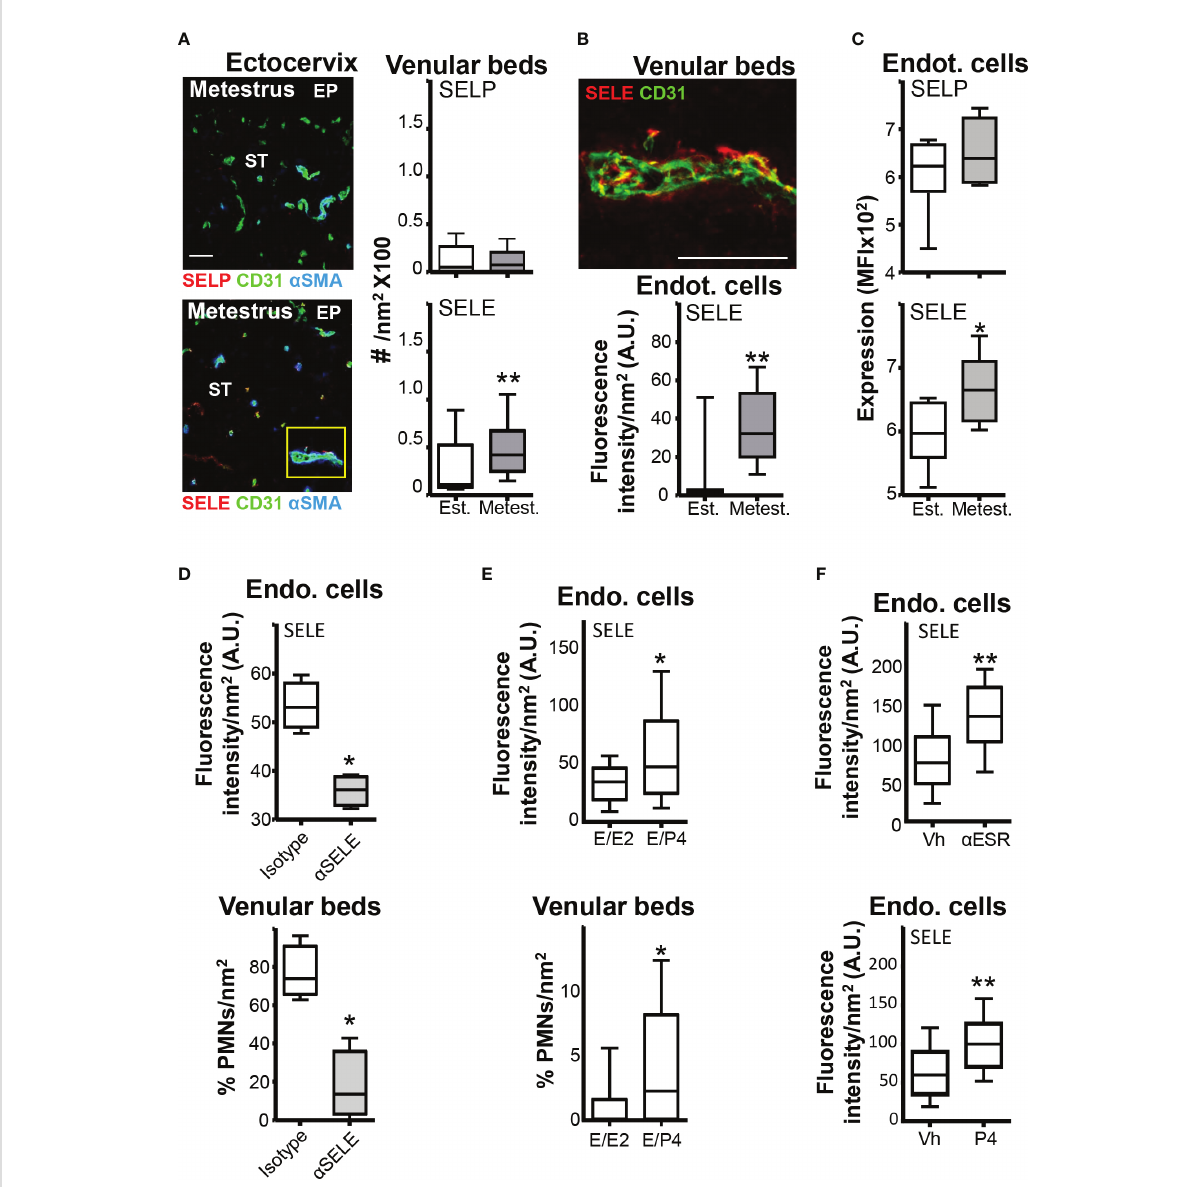
FIGURE 4 SELE and SELP expression in the ectocervix venular beds. Adult female mice were selected by vaginal smear. (A) Photomicrograph of the vascular and venular beds SELP or SELE stained in the ectocervix of estrus and metestrus mice and quanti fi cation. (B) Photomicrograph of the yellow square in (A) Endothelial cells from venular beds SELE stained in the ectocervix of estrus and metestrus mice and quanti fi cation of the expression. A and B data were calculated in at least 3 different sections of each sample (n=6 mice per group). (C) Flow cytometry average MFI of the SELP or SELE expression in the vaginal venular endothelial cells (n=6 mice per group). (D) Anti-SELE treated mice. SELE expression in endothelial cells and quanti fi cation of neutrophils intraluminal adhesion in venular beds. (E) Hormone-treated ovariectomized mice. SELE expression in endothelial cells and quanti fi cation of neutrophils intraluminal adhesion in venular beds. (F) Proestrus mice treated with ESR1 inhibitor Faslodex (250 mg) or P4 Prolutex (25 mg). Quanti fi cation of SELE expression in endothelial cells in proestrus mice treated with P4 or E2 inhibitor. Data were expressed as box and whiskers 10-90 percentile (n= 5 – 6 mice per group). *p < 0.05 and **p < 0.01 Mann-Whitney. Est, Estrus; Metest, Metestrus; E2, Estradiol; P4, Progesterona; Vh, Vehicle; Endo. cells, Endothelial cells and A.U., arbitrary